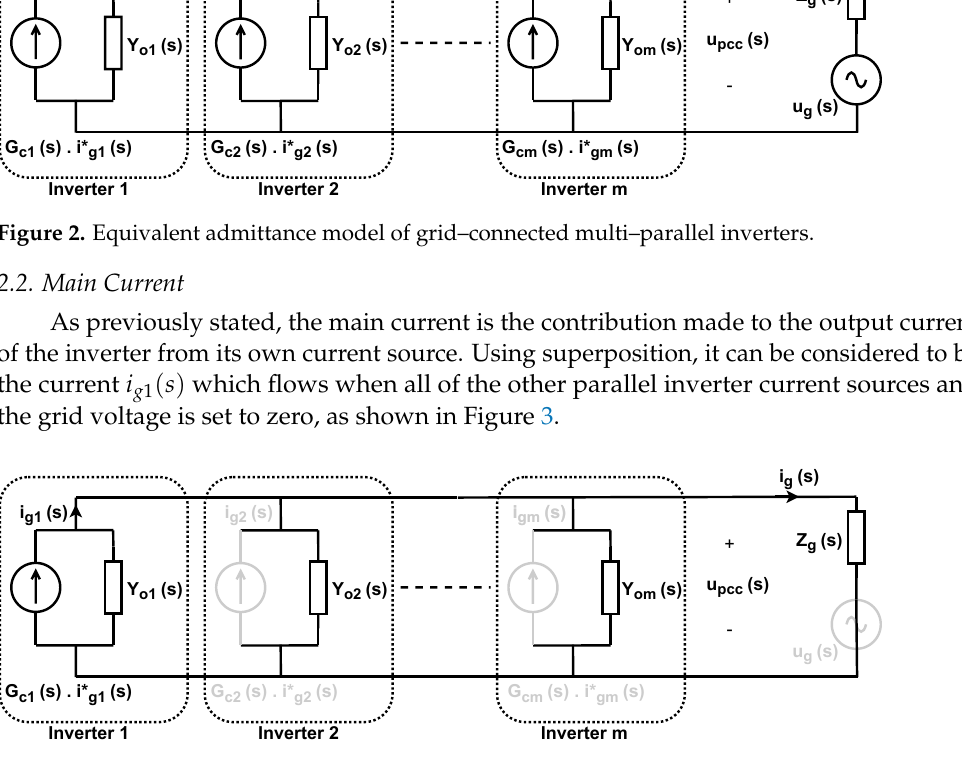
Figure 3. Equivalent admittance model for the contribution made by the inverter from its own current